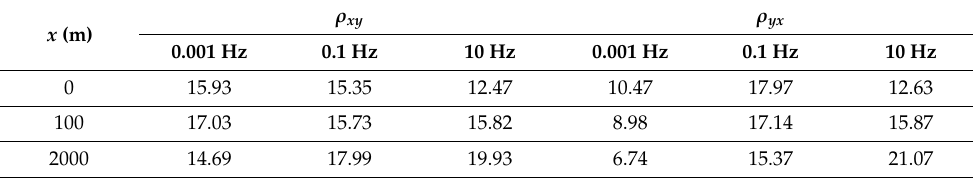
Table 7. The apparent resistivities calculated by the FE method for Model 12, as shown in Table 6. The apparent resistivity unit is Ω m. The y -coordinate is 0